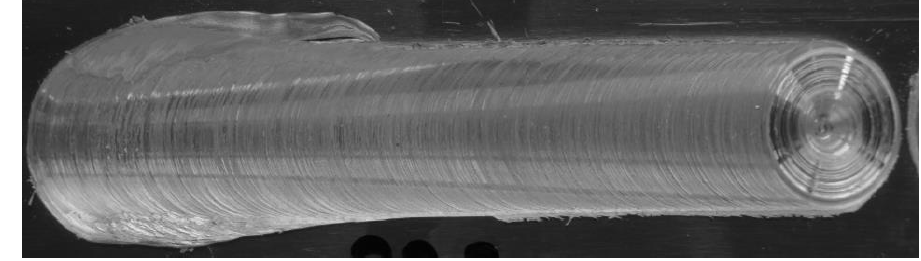
Figure 6. Sample 999.